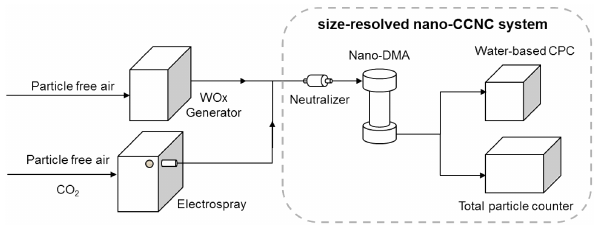
Figure 4. Schematic of the laboratory calibration. The proposed size-resolved nano-CCNC system is marked within the dashed